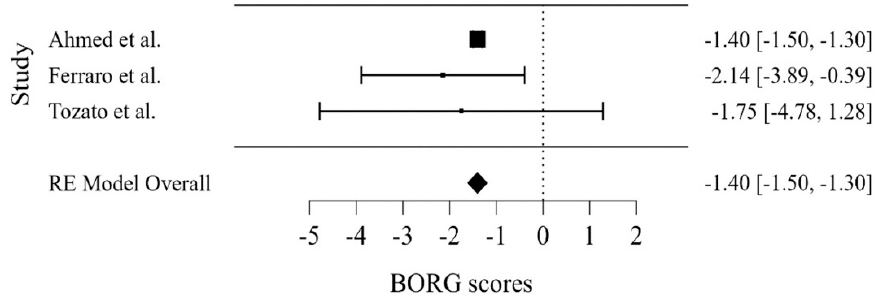
Figure 2. Forest plot of Borg Scale [44,45,47].